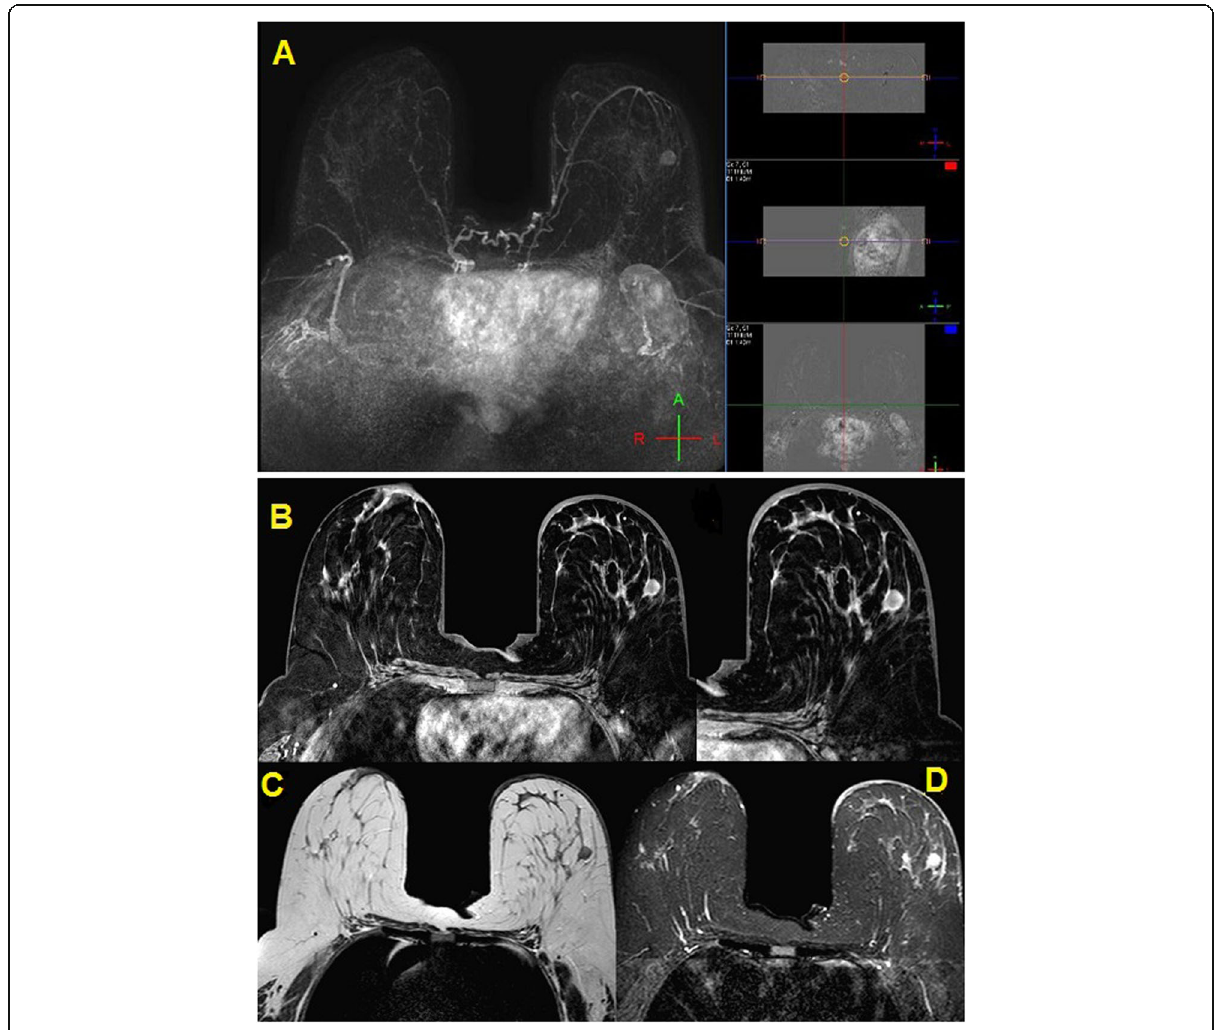
Fig. 1 MR images: a DCE-MRI MIP images, b post-contrast, c T2 WI, and d STIR WI. The images show left UOQ small not circumscribed (speculated) cystic mass lesion “ arrow, ” eliciting intermediate T2 and high (bright) T2 STIR signal intensity. It shows rim enhancement on dynamic post-contrast images and markedly enlarged axillary lymph nodes (yellow arrow). The pathology revealed TN invasive ductal